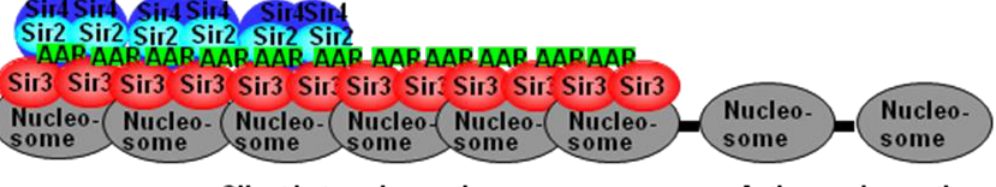
Figure 6. The proposed model of polySir3-AAR on telomeres. On the initial establishment step of silent heterochromatin formation, Sir2 associates with Sir3 and Sir4 as an SIR complex, and then a repeated recruitment cycles of SIR complexes along the adjacent chromatin region to form a silent heterochromatin domain. In the extended silent heterochromatic region, additional maturation processes like AAR continue to be associated with Sir3, in the absence of Sir2 and Sir4, which stabilize and maintain the silent heterochromatin. Figure S1: Relative amounts of Sir proteins in cells for wild type and ysa1 -deleted strains, Table S1: List of strains used in this study, Table S2: Primers used in qRT-PCR